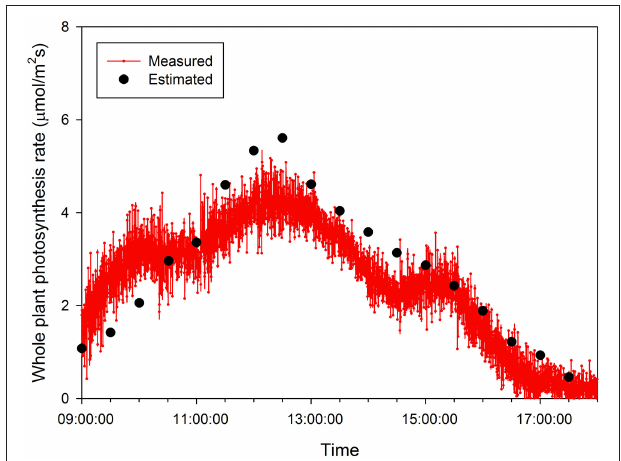
FIGURE 8 | Estimation of the average intercepted irradiation by leaf layer number from the ray-tracing simulation. The detected sample was a center plant inside a 3 × 3 canopy cultivation